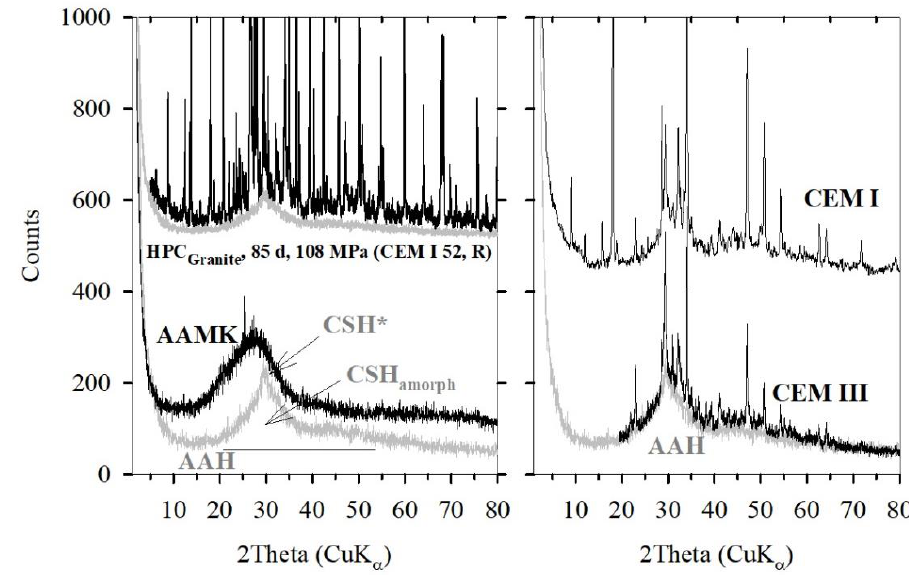
Figure 7. XRD-diagrams of AAMK, AAH and of a high strength concrete, HPC, ( left ) compared to those of pastes of CEMI, CEMIII ( right ). The AAH pattern is shown three times for better direct comparison to AAMK, HPC and CEMIII pattern.